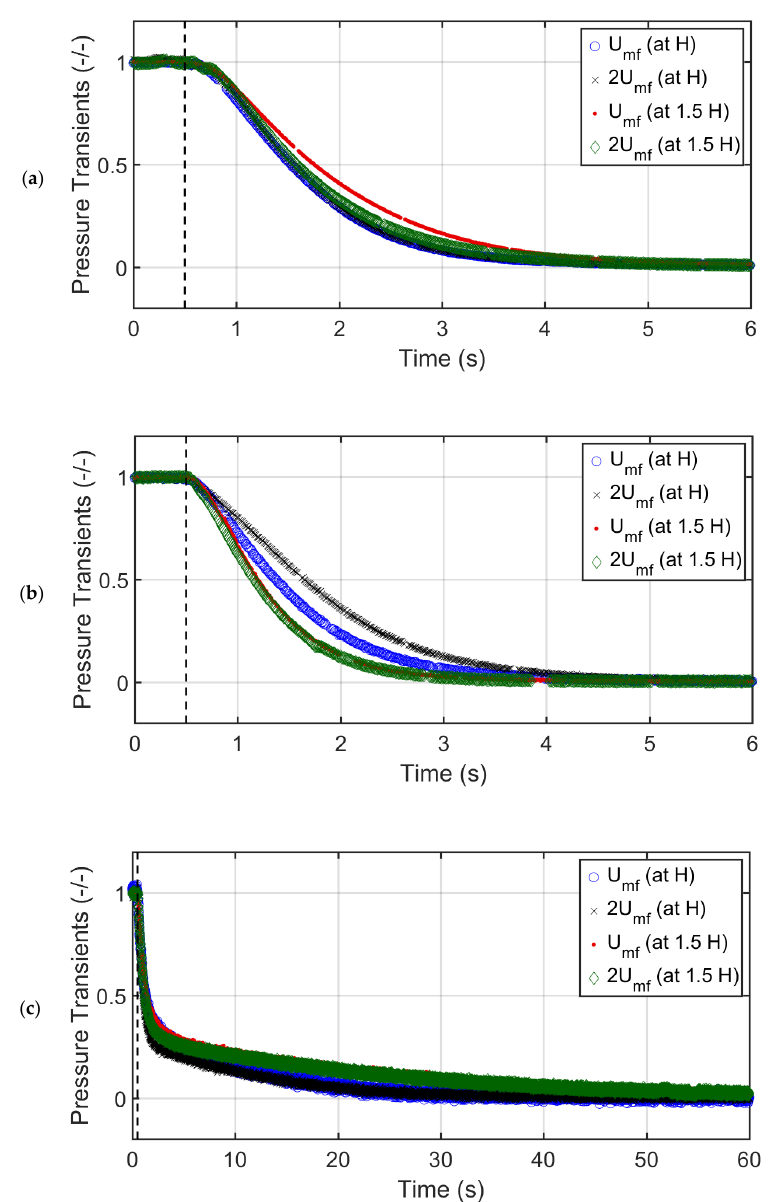
Figure 10. Global pressure drop of the collapsing particles bed at U mf and 2 U mf bed heights H and 1.5 H for ( a ) glass beads, ( b ) titania, and ( c ) nanosilica.